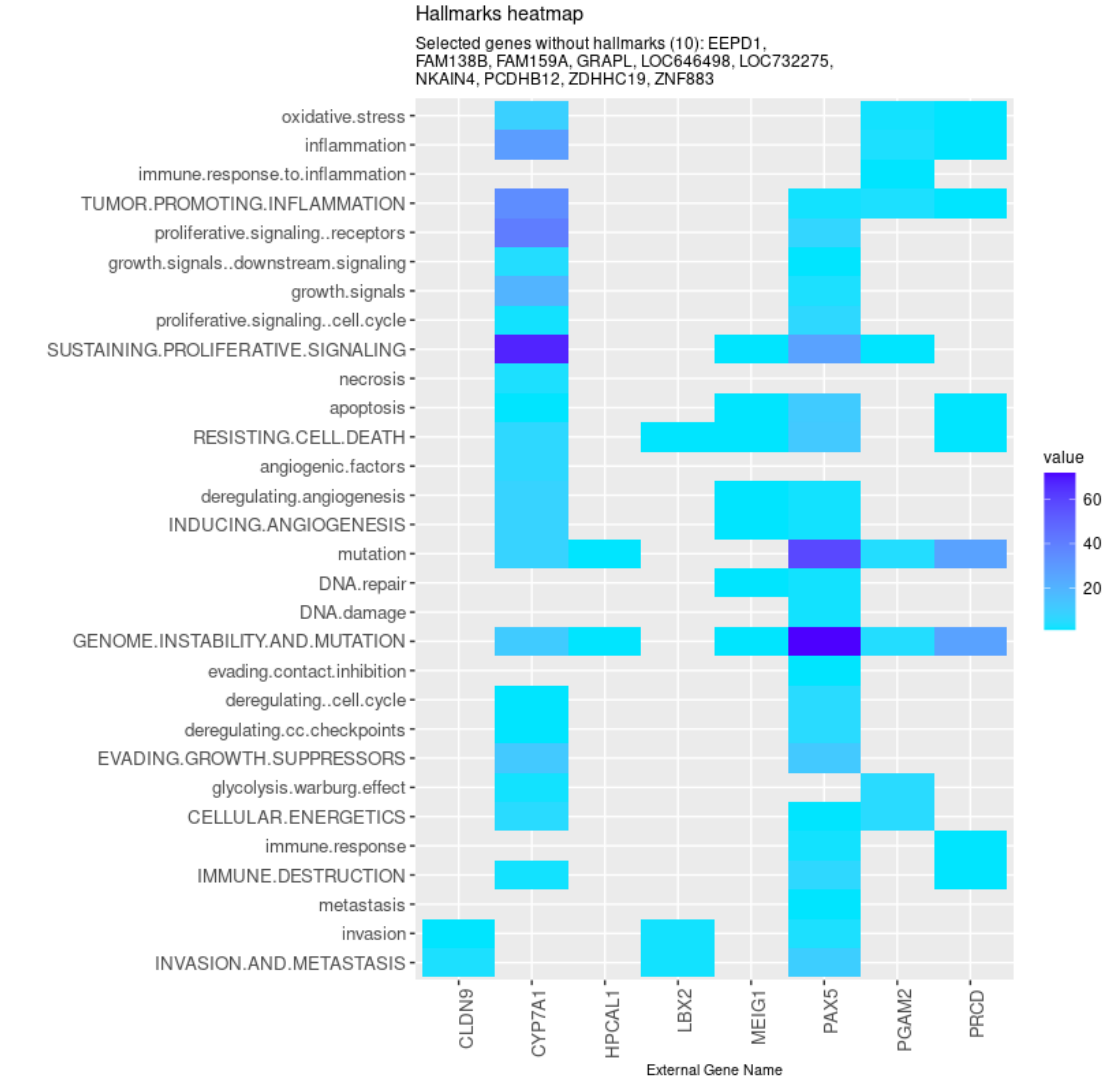
Figure 6. Genes selected by all models tested associated with the hallmarks of cancer, given by the CHAT. Value corresponds to the number of hits found in the literature, where light and dark blue correspond to a low and high number of hits,